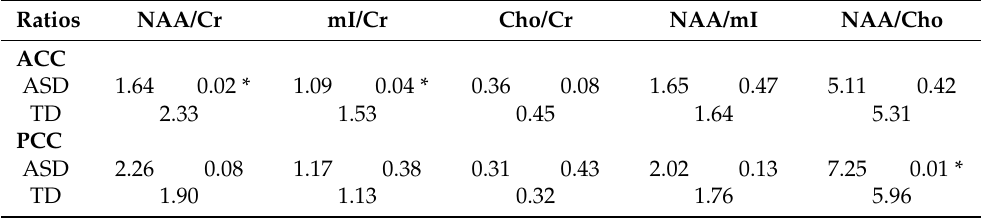
Table 3. Comparing the metabolite ratios between the ASD (n = 22) and TD ( n = 43) groups in the ACC and the PCC using the Student’s t -test. m = average of the ratios, * = significant differences. p < 0.05 considered significantly different.